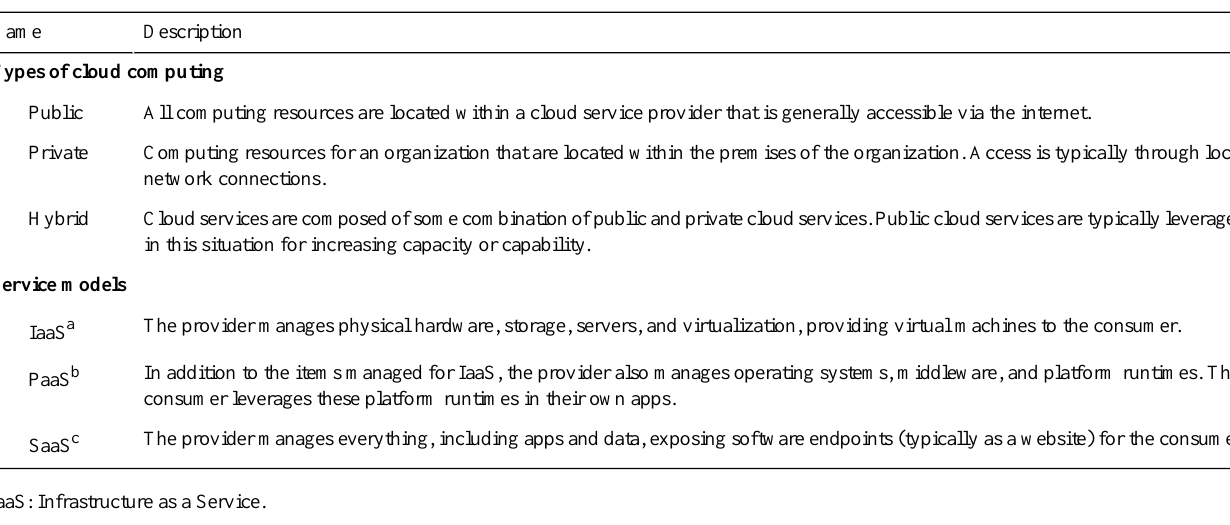
Table 1. Overview of cloud computing types and service